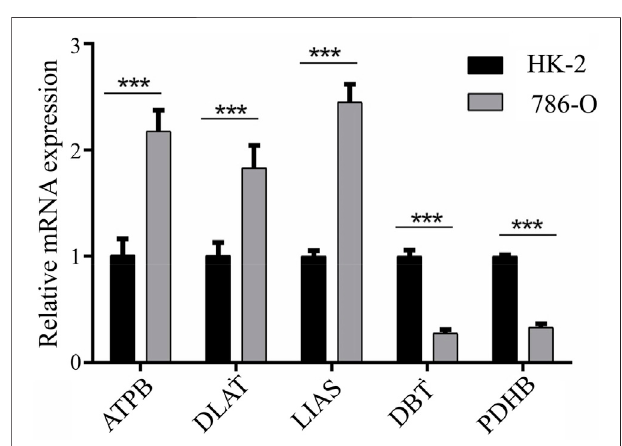
FIGURE 6 | Results of qPCR for fi ve genes between HK-2 and 786-O cell